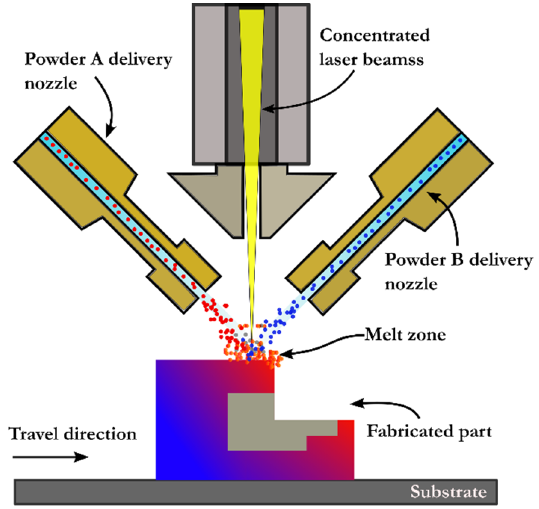
Figure 10. Process description of depositing multiple materials using DED process .